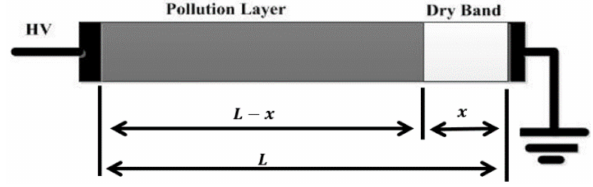
Figure 4. Dry band near ground